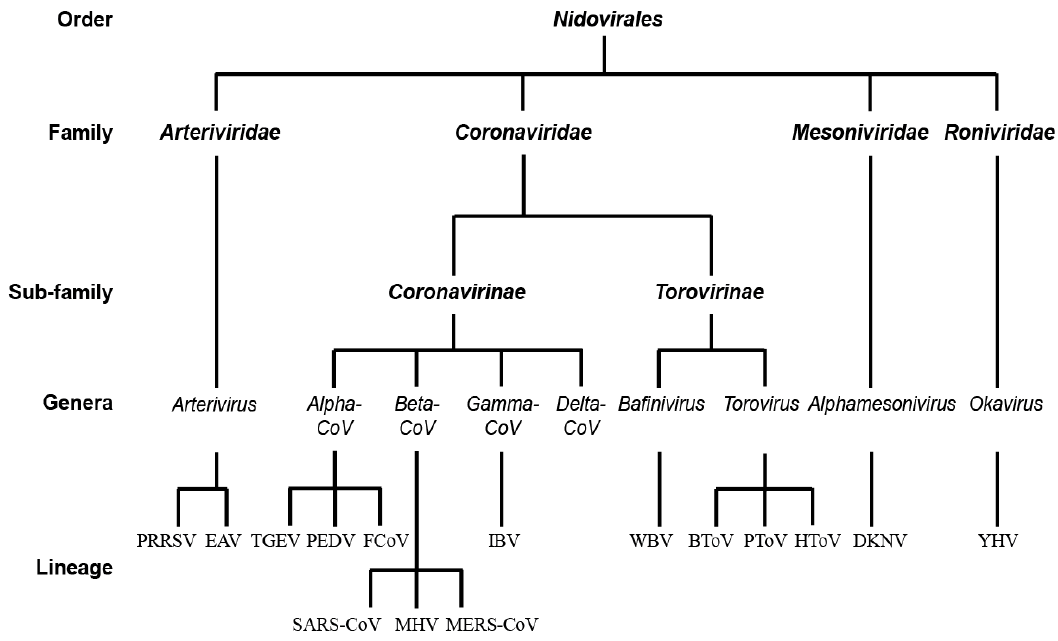
Figure 1. The taxonomy of the order Nidovirales . BToV, bovine torovirus; DKNV, dak nong virus; EAV, equine arteritis virus; FCoV, feline coronavirus; HToV, human torovirus; IBV, infectious bronchitis virus; MERS-CoV, Middle East respiratory syndrome coronavirus; MHV, mouse hepatitis virus; PRRSV, porcine reproductive and respiratory syndrome virus; PEDV, porcine epidemic diarrhea virus; PToV, procine torovirus; TGEV, transmissible gastroenteritis coronavirus; SARS-CoV, severe acute respiratory syndrome coronavirus; YHV, yellow head virus; WBV, white bream virus.